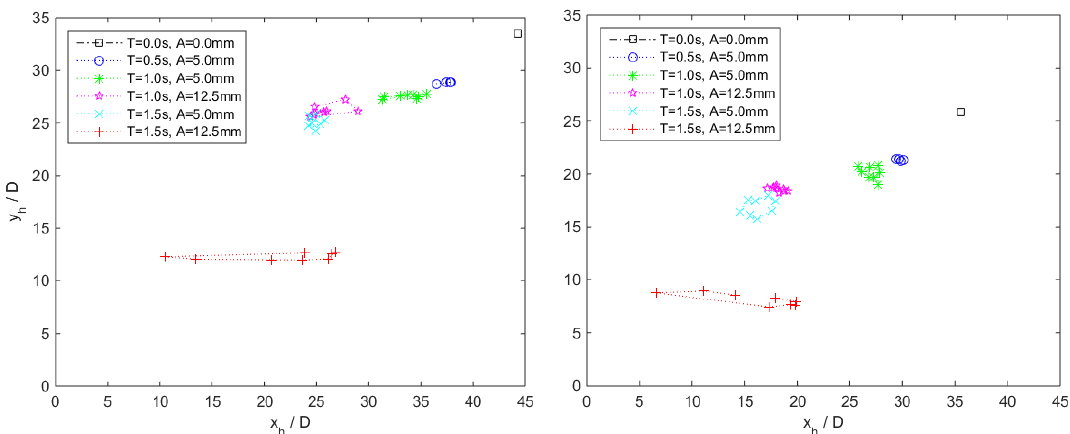
Figure 7. Trajectories of the maximum height points for the NBJs with Fr = 28.0 ( left ) and Fr = 18.0 ( right ) released into a receiving body affected by regular waves (wave parameters in the legend).